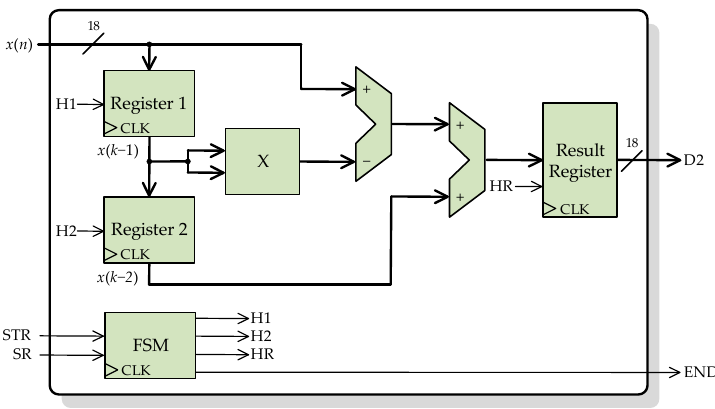
Figure 7. Architecture of the processing core for computing the second-order difference function.